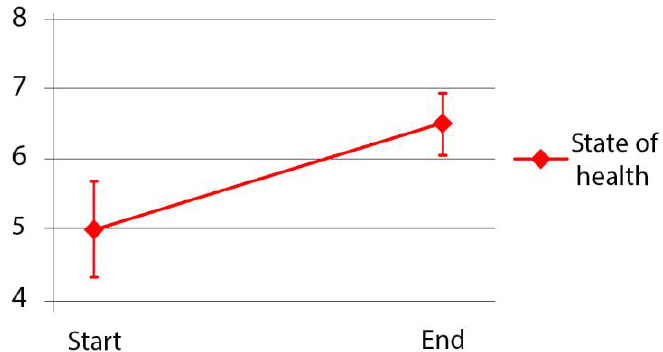
Figure 12. The development in the participants’ general health based on EQ-VAS from start to end of NBTN ( n = 33).